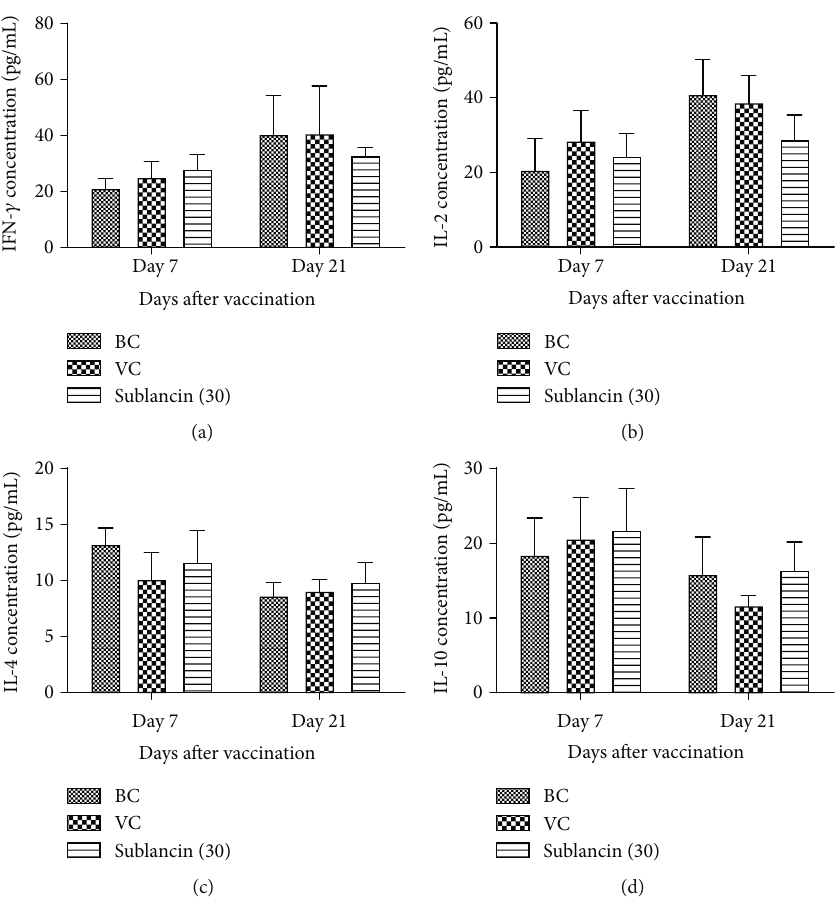
Figure 6: The changes of serum (a) IFN- γ , (b) IL-2, (c) IL-4, and (d) IL-10 concentrations in each group in Exp.